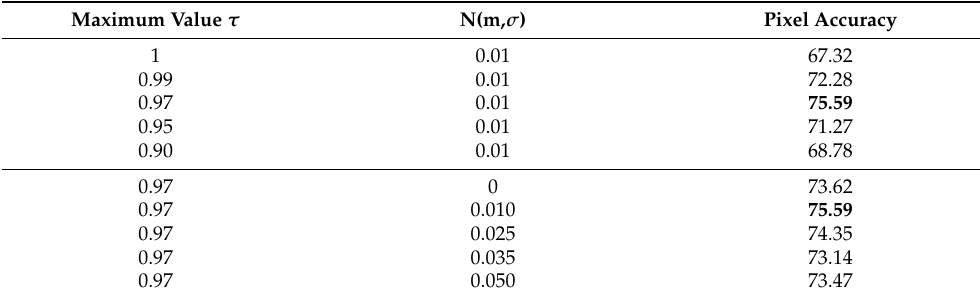
Table 6. Result on various